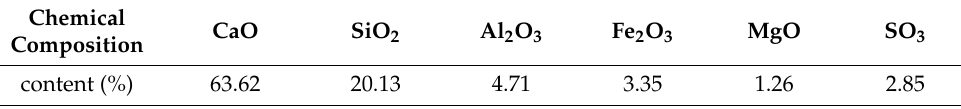
Table 2. Chemical composition of cement.